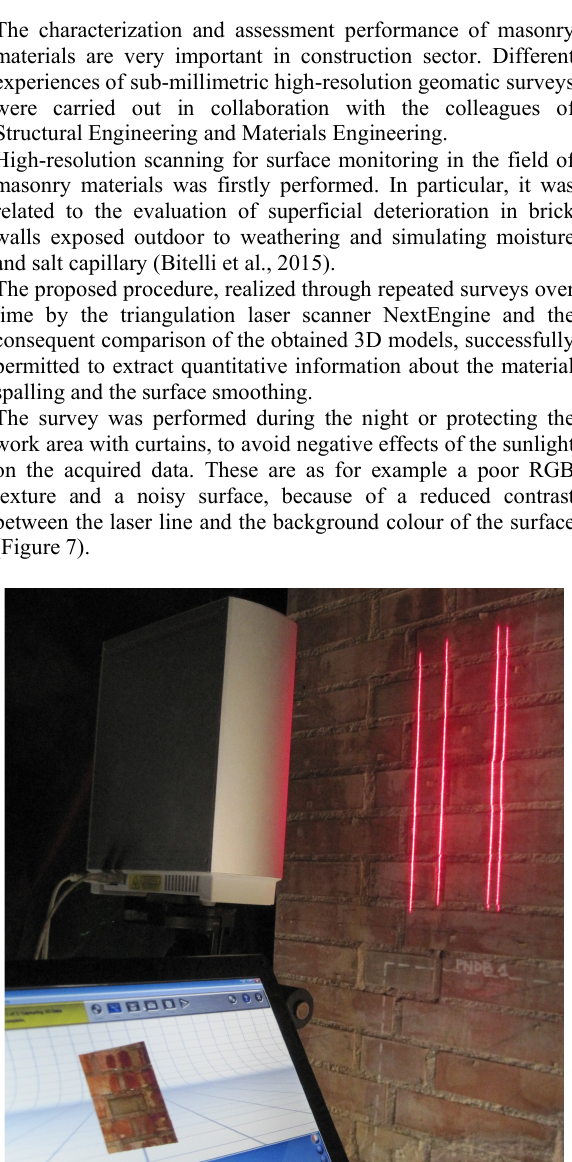
In Figure 9 are shown some examples related to the brick indicated by the red rectangle in Figure